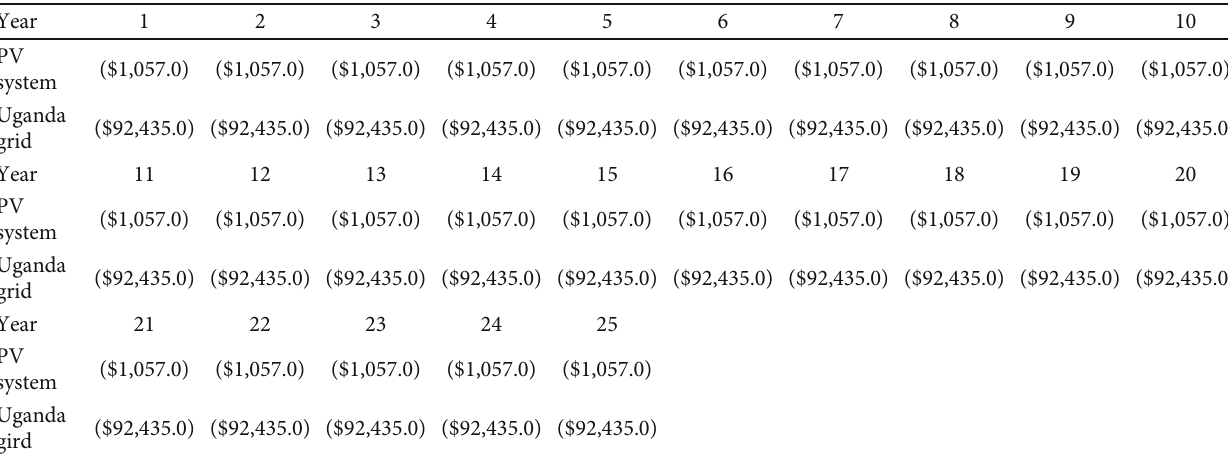
Figure 13: The electrical production for both utility and solar PV microgrid for the proposed technology in Uganda. Table 3: Project cost details (both grid and PV systems) for the whole project lifetime in